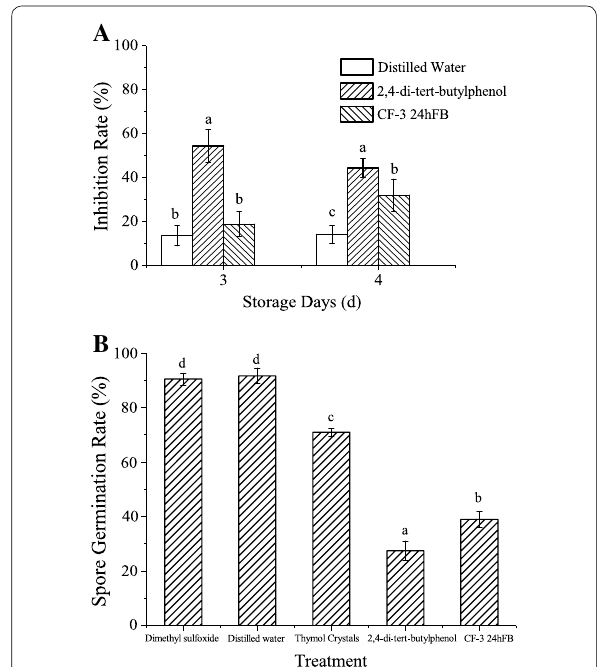
Fig. 1 Inhibitory effect of different treatments on C. gloeosporioides ( A ) and spores’ germination ( B ) of C. gloeosporioides. Each column represents the mean value from three independent experiments, and vertical bars represent the standard errors of the means for each treatment. Different letters represent significant differences ( P < 0.05